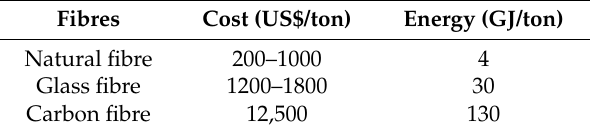
Table 4. Energy and cost of different fibres